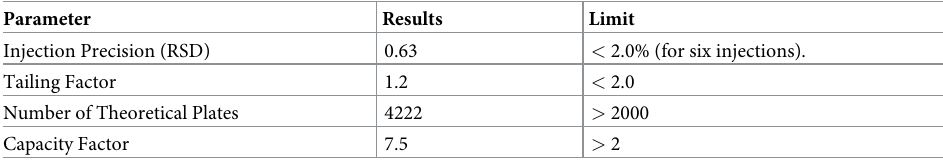
Table 5. Summary results of system